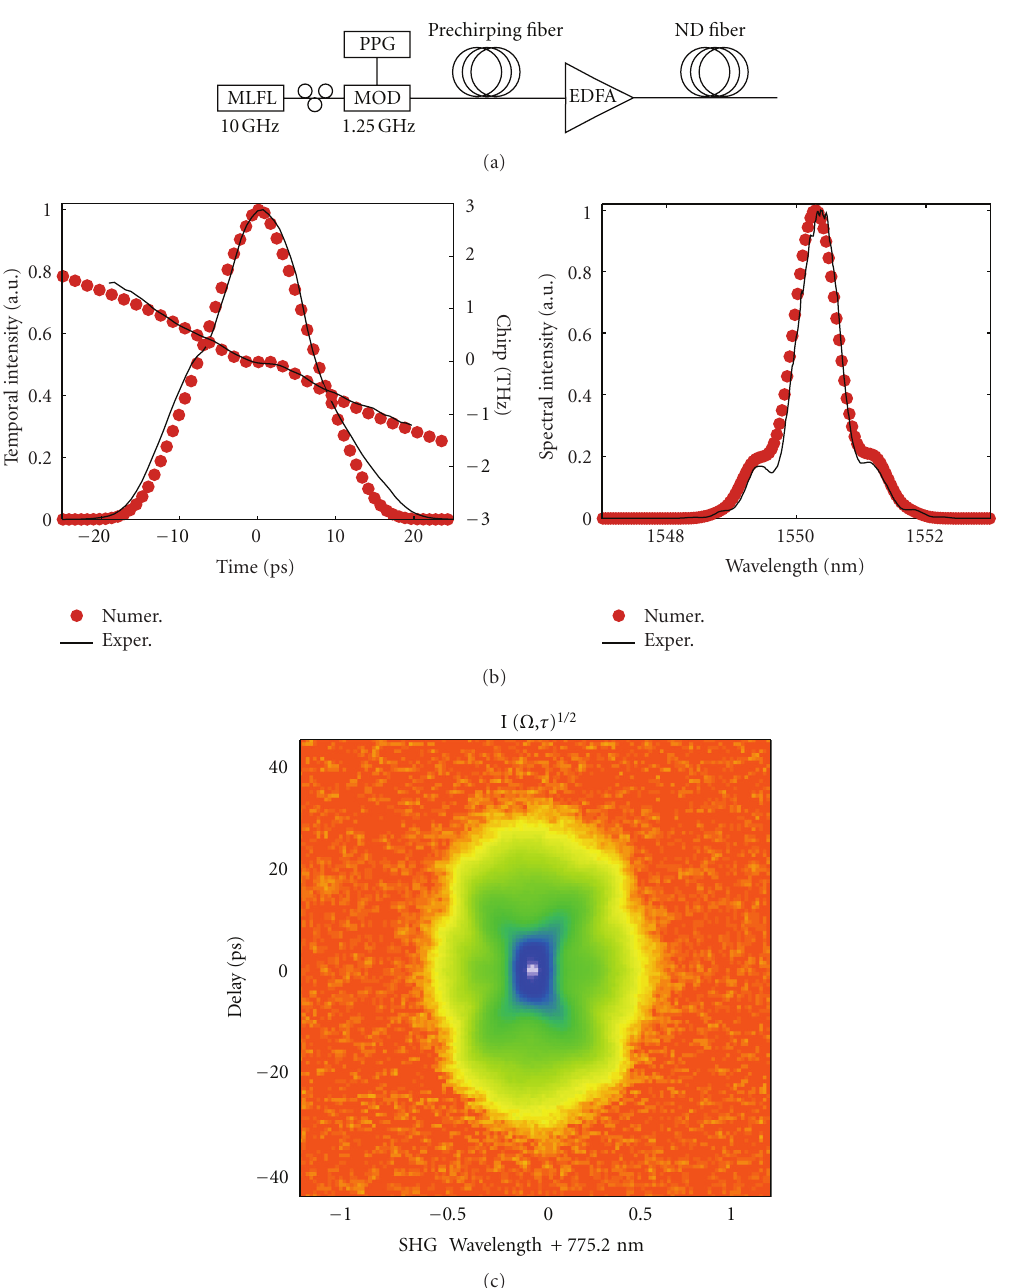
Figure 3: (a) Experimental setup for triangular pulse generation. (b) Experimental and numerical temporal intensity and chirp ( φ t ) profiles retrieved from second-harmonic generation (SHG) FROG (left) and optical spectra (right) of the generated pulses for an example length of prechirping fibre. (c) SHG-FROG spectrogram of the pulse in (b). Results adapted from [72].